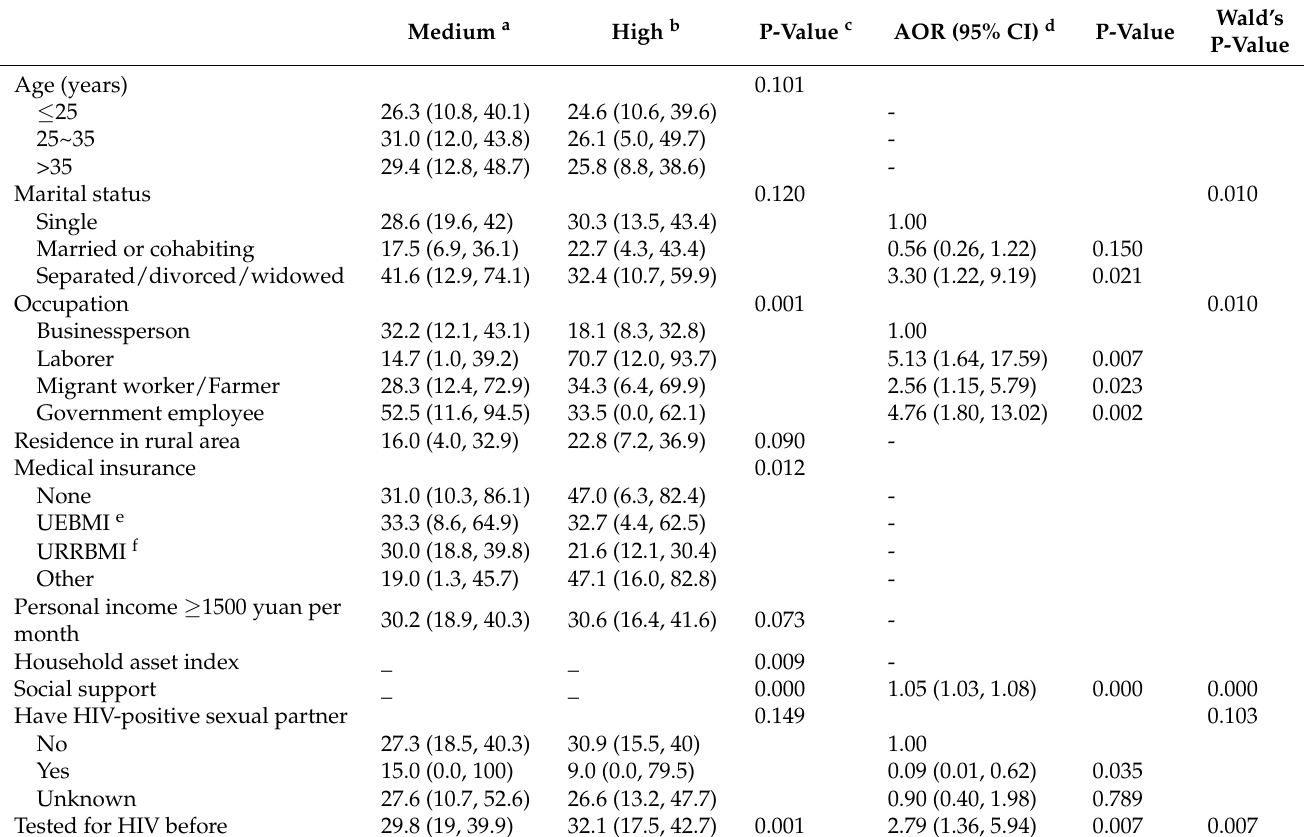
Table 5. Univariate and multivariate ordinal logistic regression analysis of factors associated with the acceptability of